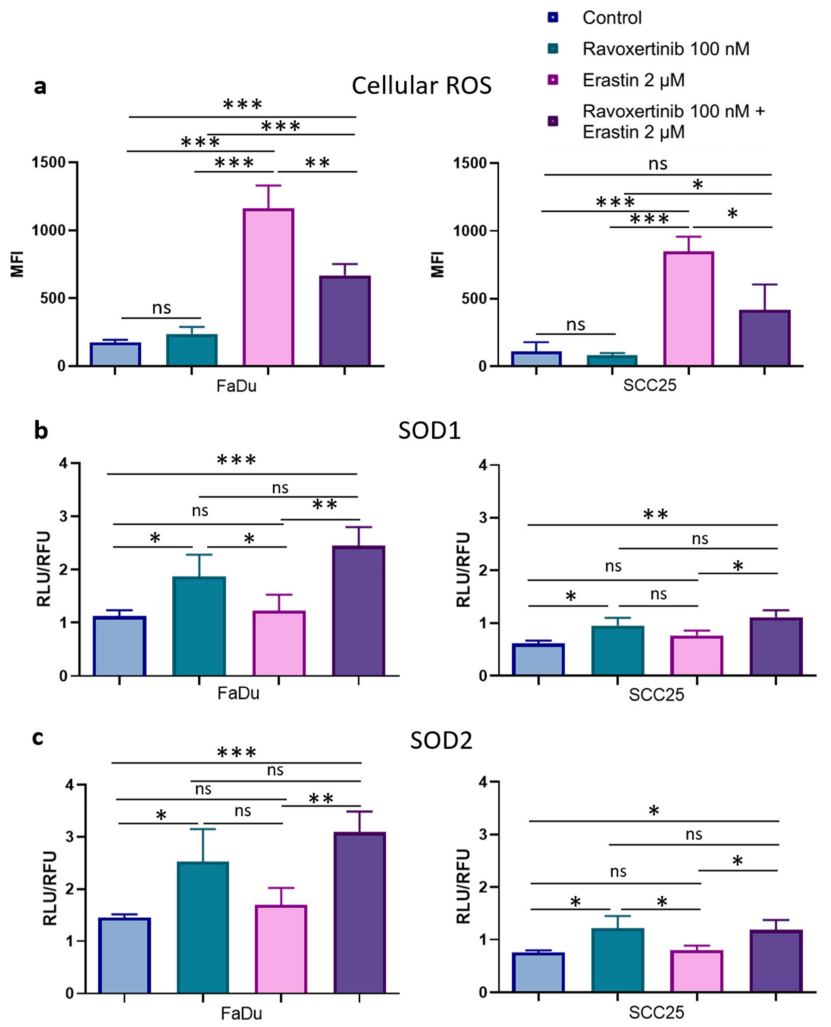
Figure 7. ROS production and expression of ROS scavengers, SOD1, and SOD2 in HNSCC cells. Flow cytometry analysis of the HNSCC cells stained with DCFDA fluorogenic dye was used to measure hydroxyl, peroxyl, and other ROS activities in FaDu and SCC25 cells 24 h after treatment with erastin (2 µ M), ravoxertinib (100 nM), or their combination ( a ). Expression levels of ROS scavengers SOD1 ( b ) and SOD2 ( c ) were evaluated using the Promega Lumit™ Immunoassay Cellular System (see Materials and Methods) 24 h after treatment with erastin (2 µ M), ravoxertinib (100 nM), or their combination. Data are given as mean + SD ( a ) or mean + SEM ( b , c ) obtained from at least three independent experiments, * p < 0.05, ** p < 0.01, *** p <